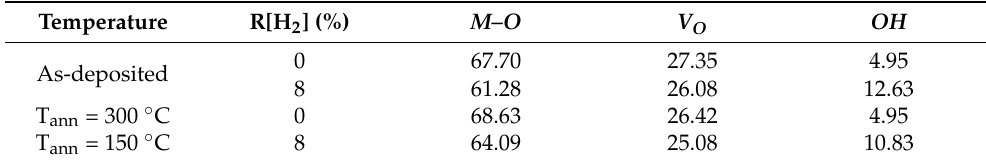
Table 3. Relative area ratio of the metal-oxygen ( M–O) , oxygen vacancies ( V O ) and